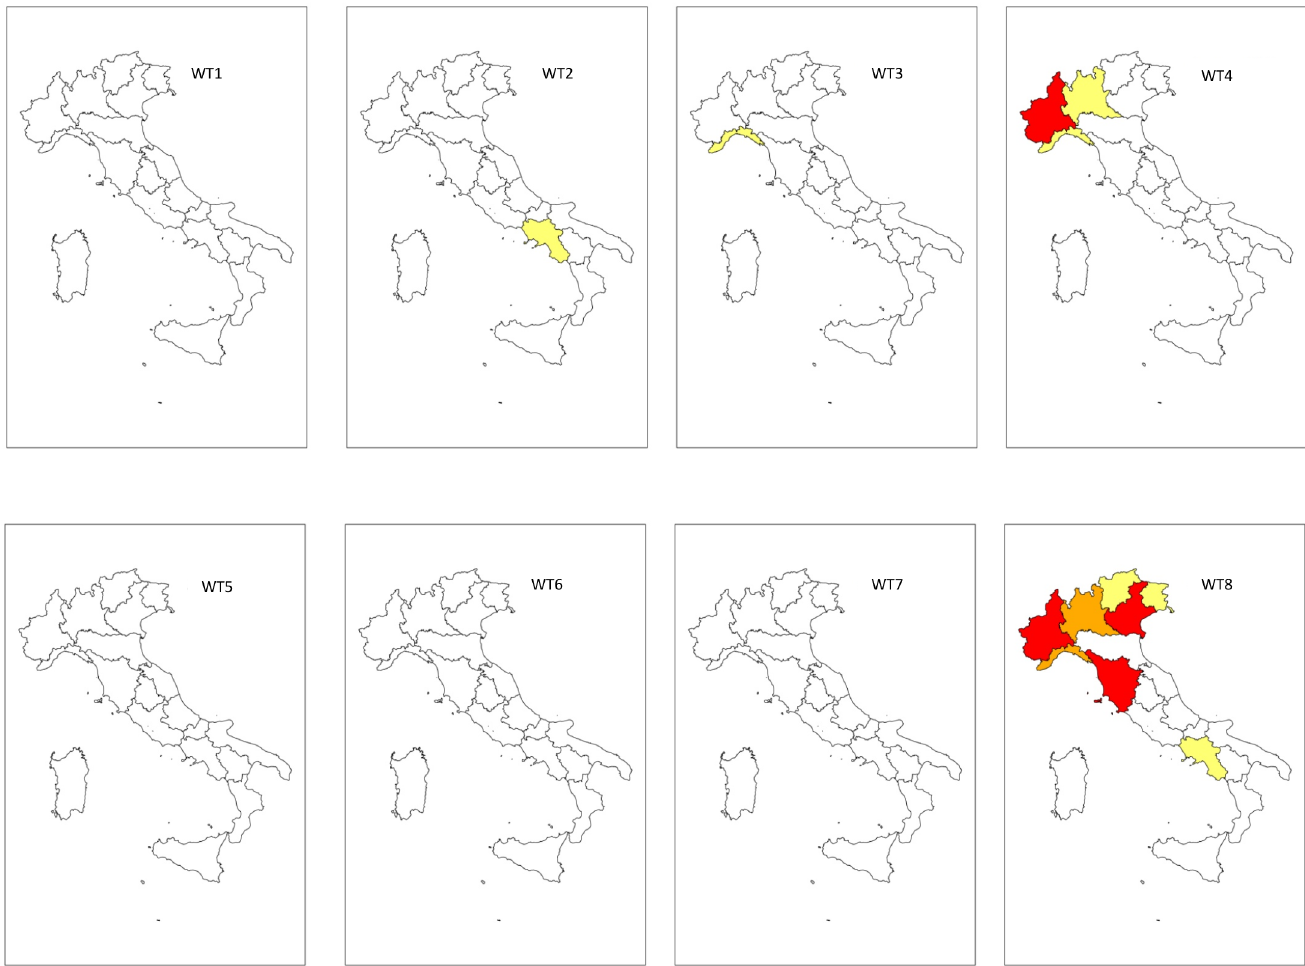
Fig 5. Mapping of the autumn WT-related Floods and LAndslides Risk Index (WT-FLARI). WT (Weather Type). WT-FLARI levels: red = Very High (WT-FLARI > 99 th perc.); orange = High (95 th perc. > WT-FLARI > 99 th perc.); yellow = Moderate (95 th perc. > WT-FLARI > 90 th perc.); white = Low (WT-FLARI < 90 th